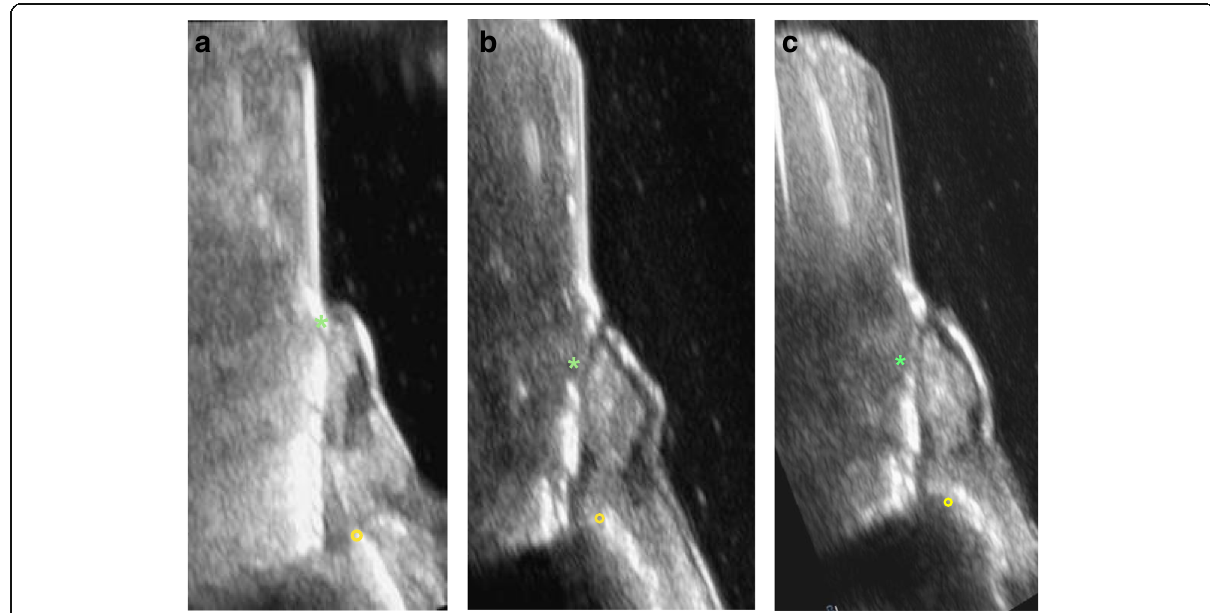
Fig. 6 a Ultrasonic imaging at the implant in region 33 revealed buccal bone loss up to the 6th thread (asterisk marks the implant-abutment interface; circle marks the bone). b Ultrasonic imaging at the implant region 34 revealed buccal bone loss up to the 3rd implant thread (asterisk marks the implant-abutment interface; circle marks the bone). c Ultrasonic imaging at the implant region 35 revealed buccal bone loss up to the 2nd implant thread (asterisk marks the implant-abutment interface; circle marks the